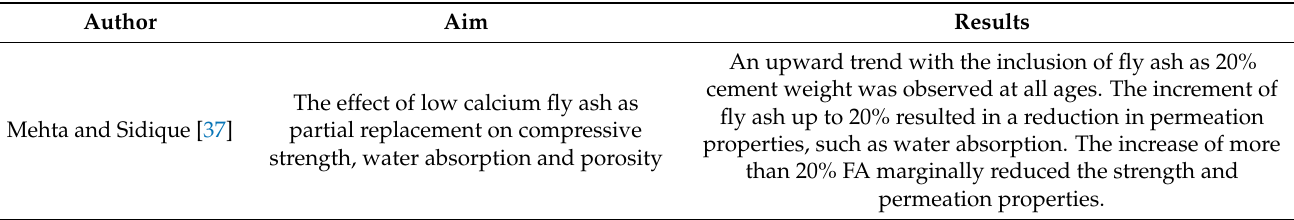
Figure 5. Effect of alkaline solution to binder (Al/Bi) ratio and sodium silicate solution to sodium hydroxide solution (SS/SH) ratio on compressive strength of geopolymer paste compared to conventional concrete (OPC) [41]. Table 3. Effect of combined concrete with diverse Portland cements and fly ash on improvement of concrete mechanical and permeation